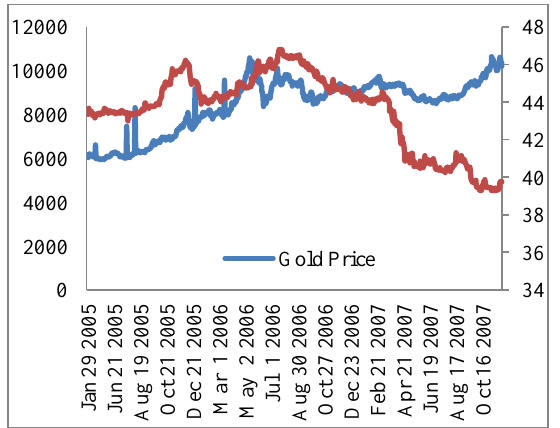
Fig. 1 The Exchange Rate of US Dollar to INR and Gold